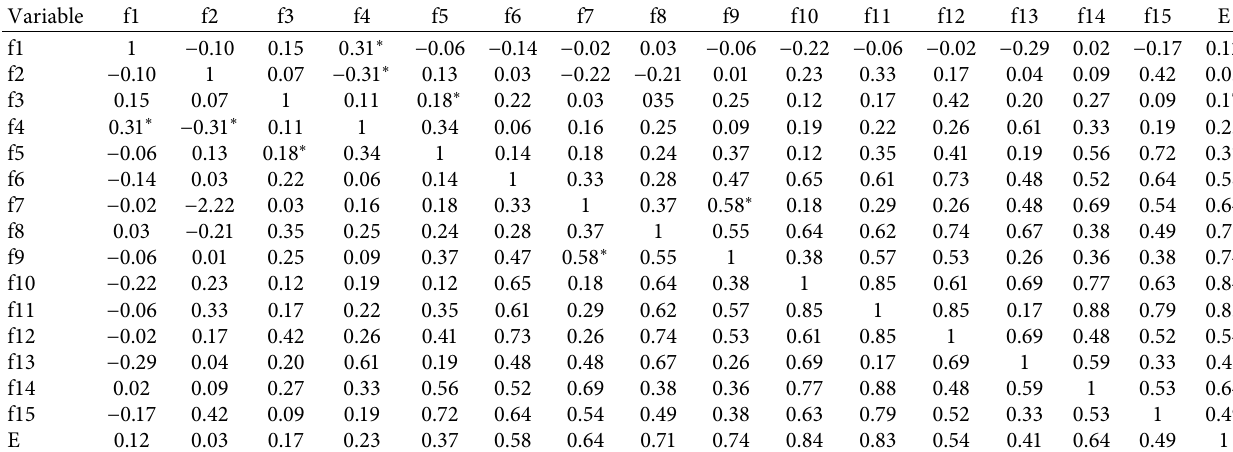
Table 4: Correlation test of